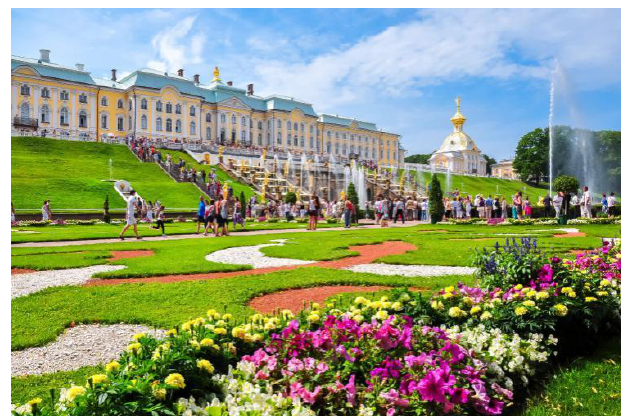
Figure 11. Gardens of Peterhof (St. Petersburg, Russia) Figure 12. Boboli gardens (Florence, Italy)